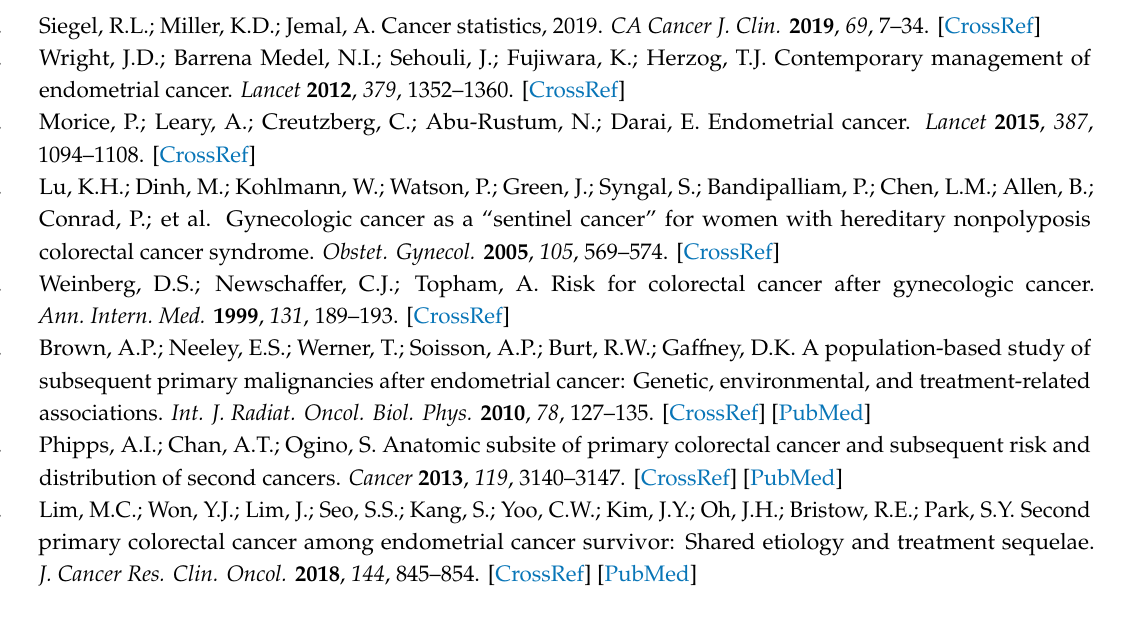
Figure S1: CONSORT diagram for study schema, Figure S2: Median follow-up time among cancer survivors, Figure S3: Trends of postcedent secondary primary cancer among cancer survivors per year stratified chronology, Figure S4: Trends in secondary primary cancer per age, Figure S5: Absolute time interval between the two cancer diagnoses per age at the index cancer diagnosis, Figure S6: Secondary primary cancer-specific survival among survivors, Figure S7: Secondary colorectal cancer among endometrial cancer, Figure S8: Secondary colorectal cancer among endometrioid type endometrial cancer, Table S1: Patient demographics (endometrial cancer cohort), Table S2: Patient demographics for endometrioid type endometrial cancer based on timing of secondary colorectal cancer, Table S3: Temporal trends of age at the index cancer diagnosis based on presence of secondary primary cancer (for Figure 1A,B), Table S4: Temporal trends for secondary primary cancer per year (for Figure 2A,B), Table S5: Temporal trends for secondary primary cancer in long-term follow-up cases (for Figure 3A), Table S6: Temporal trends of SIR for secondary primary cancer (for Figure 3B), Table S7: Temporal trends for secondary primary cancer per SPC timing (for Supplemental Figure S3), Table S8: Temporal trends for secondary primary cancer per age (for Figure 4A,B), Table S9: Temporal trends for secondary primary cancer-specific survival among survivors (for Supplemental Figure S6), Table S10: Temporal trends for secondary colorectal cancer among endometrial cancer (for Supplemental Figure S7A), Table S11: Temporal trends for postcedent colorectal cancer in long-term follow-up cases with endometrial cancer (for Supplemental Figure S7B), Table S12: Temporal trends for secondary colorectal cancer among endometrioid type endometrial cancer (for Supplemental Figure S8A), Table S13: Temporal trends for postcedent colorectal cancer in long-term follow-up cases with endometrioid type endometrial cancer (for Supplemental Figure